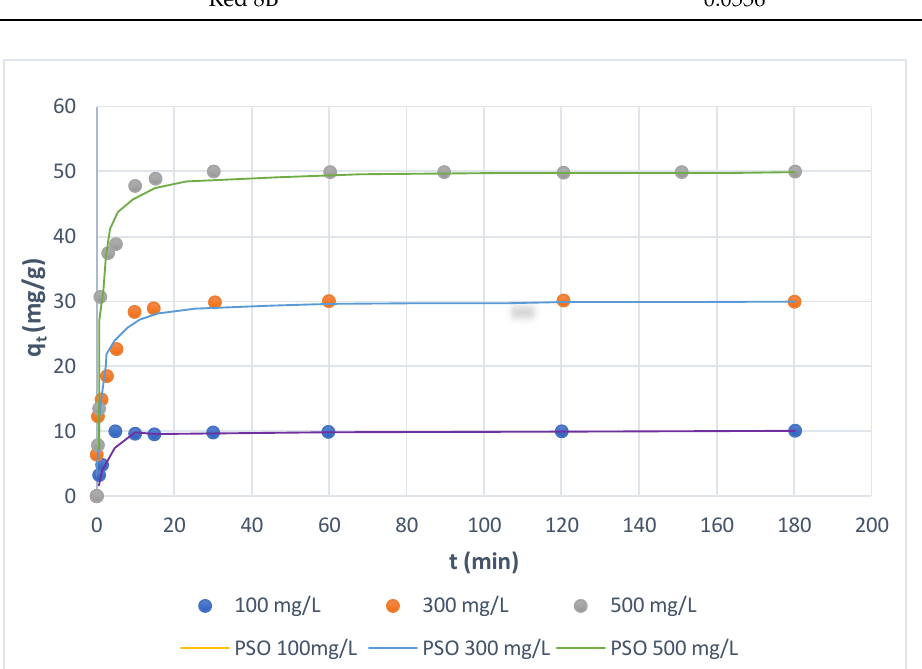
Figure 5. Effects of phase contact time and initial concentration of Direct Yellow RL on the amount of dye adsorbed by SBR.